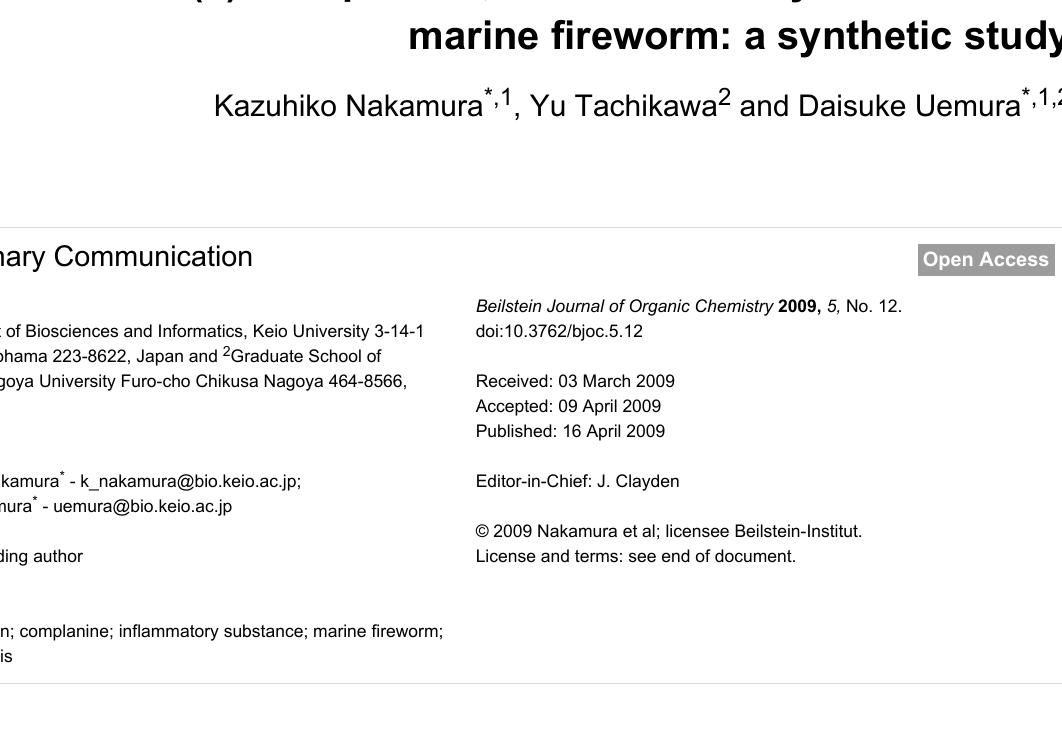
kinase C (PKC) in the presence of Ca 2+ and 12- O -tetra- decanoylphorbol 13-acetate (TPA) has been proved. These results suggest that complanine can bind PKC at the same site as phosphatidylserine, a co-activation factor with Ca 2+ and TPA. It is known that signal transduction leads to an inflamma- tion mediator TNF-α and its downstream signal molecules, which occurs by phosphorylation through the action of